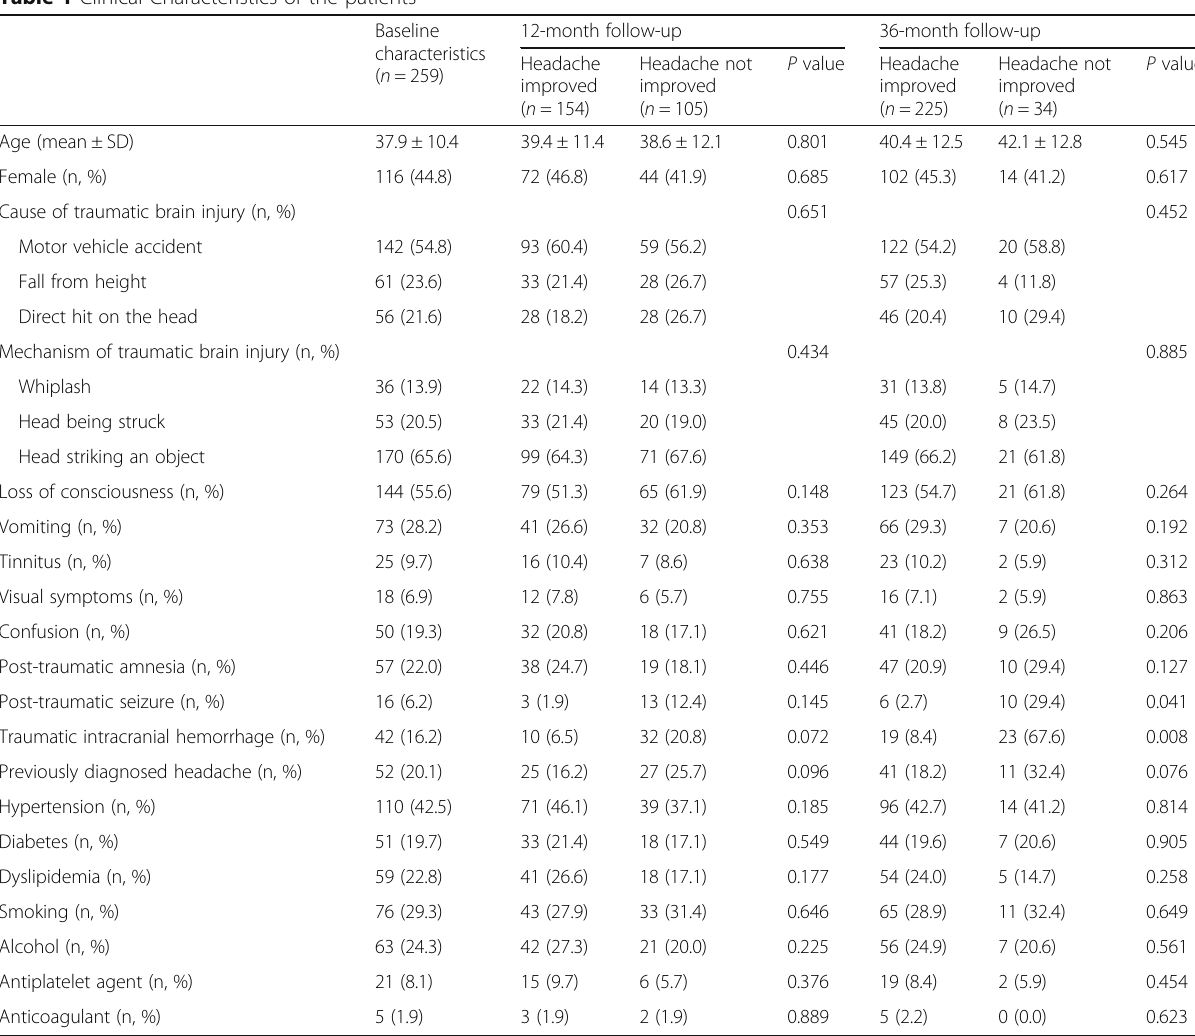
Table 1 Clinical Characteristics of the patients